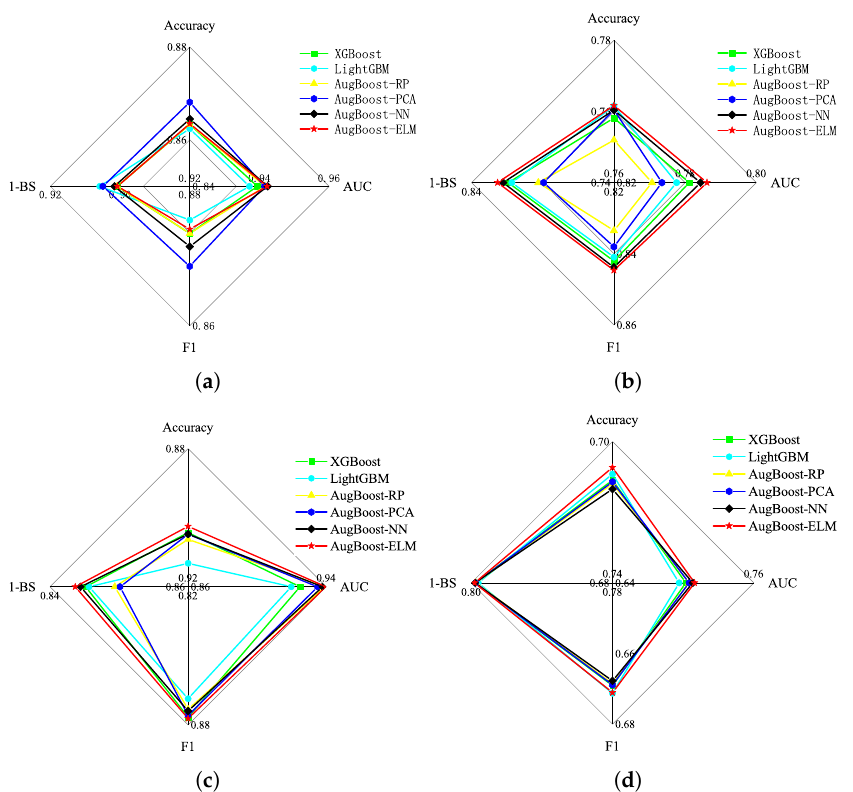
Figure 4. Comparison of testing AUC for the credit datasets. ( a ) Australian, ( b ) German, ( c ) Japanese, ( d )